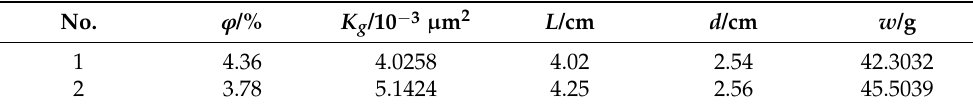
Figure 1. Cores selected in this paper. Table 1. Physical parameters of